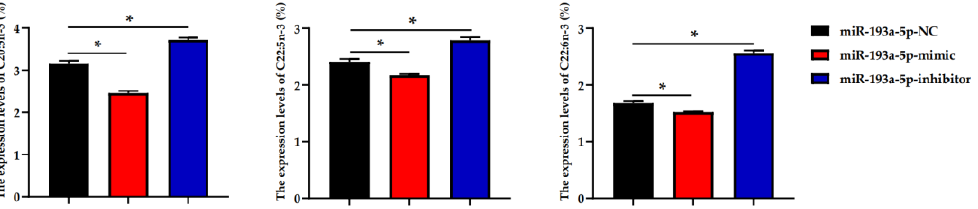
Figure 7. Effect of miR-193a-5p mimic and inhibitor on the composition of n-3 fatty acids in BMECs ( n = 6). * represents p < 0.05, indicating significant differences between the groups.